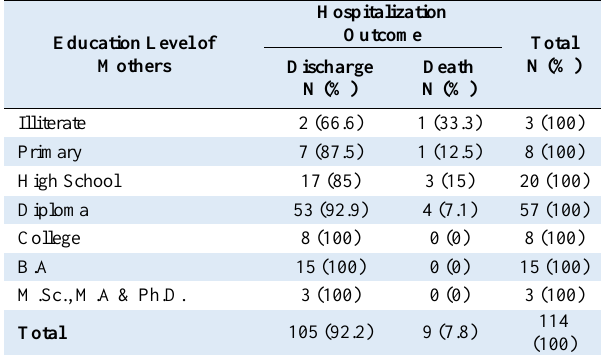
Table 4. The relationship between education level of mothers and premature infant mortality